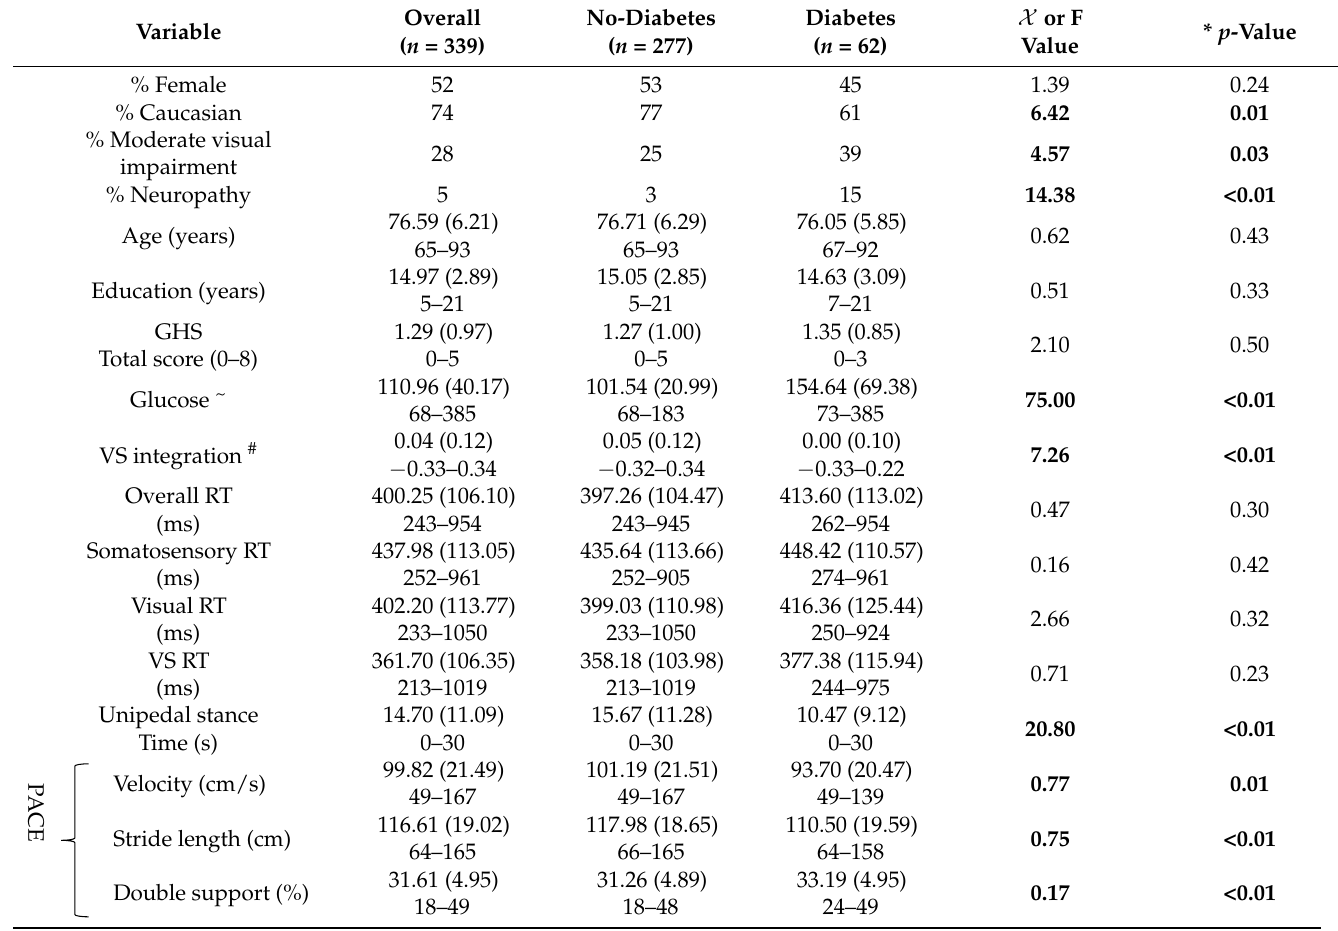
Table 1. Summary of demographic and clinical variables: overall and split by diabetes status ‡.